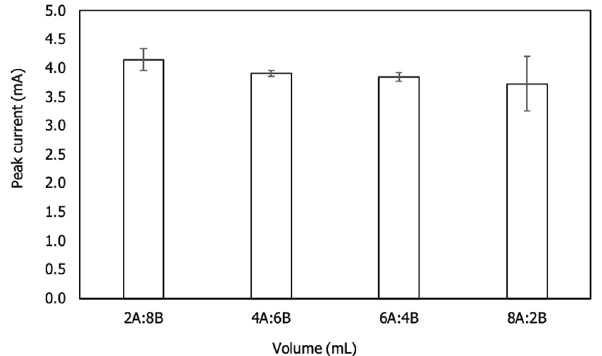
Figure 8. Bar graph was the effects of different analytical volumes (A-analyte, B-buffer) on f-MWCNTs/CS/PB/ AuE in the presence of 3 ppm Zn 2+ . The experimental conditions were 0.1 M PBS as supporting electrolyte, 200 mVs -1 of scan rate and 10 s of accumulation time.